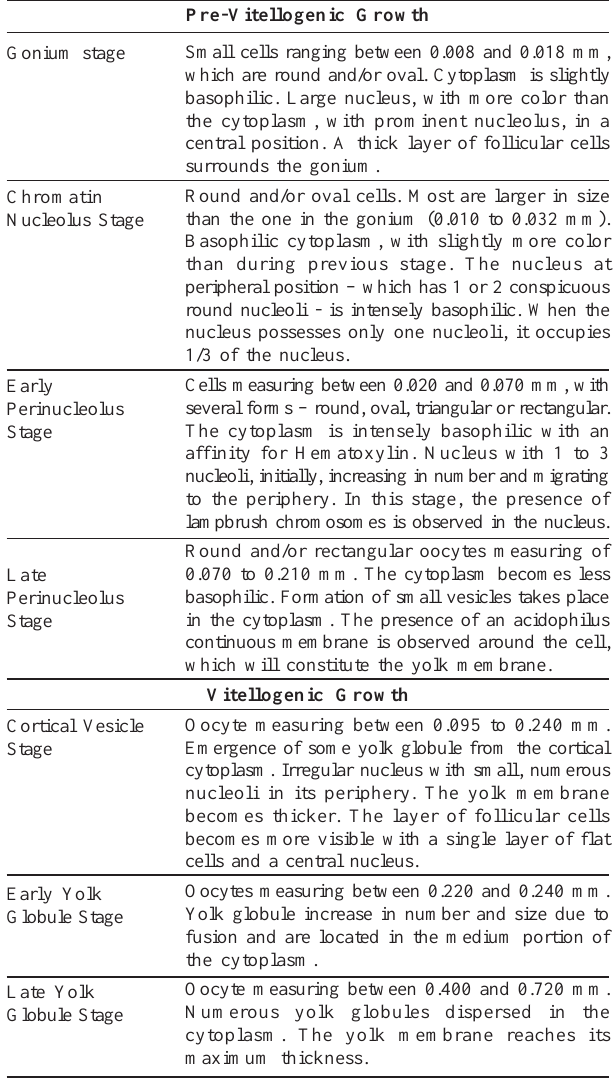
Table 1. Oocyte stages of the black grouper Mycteroperca bonaci